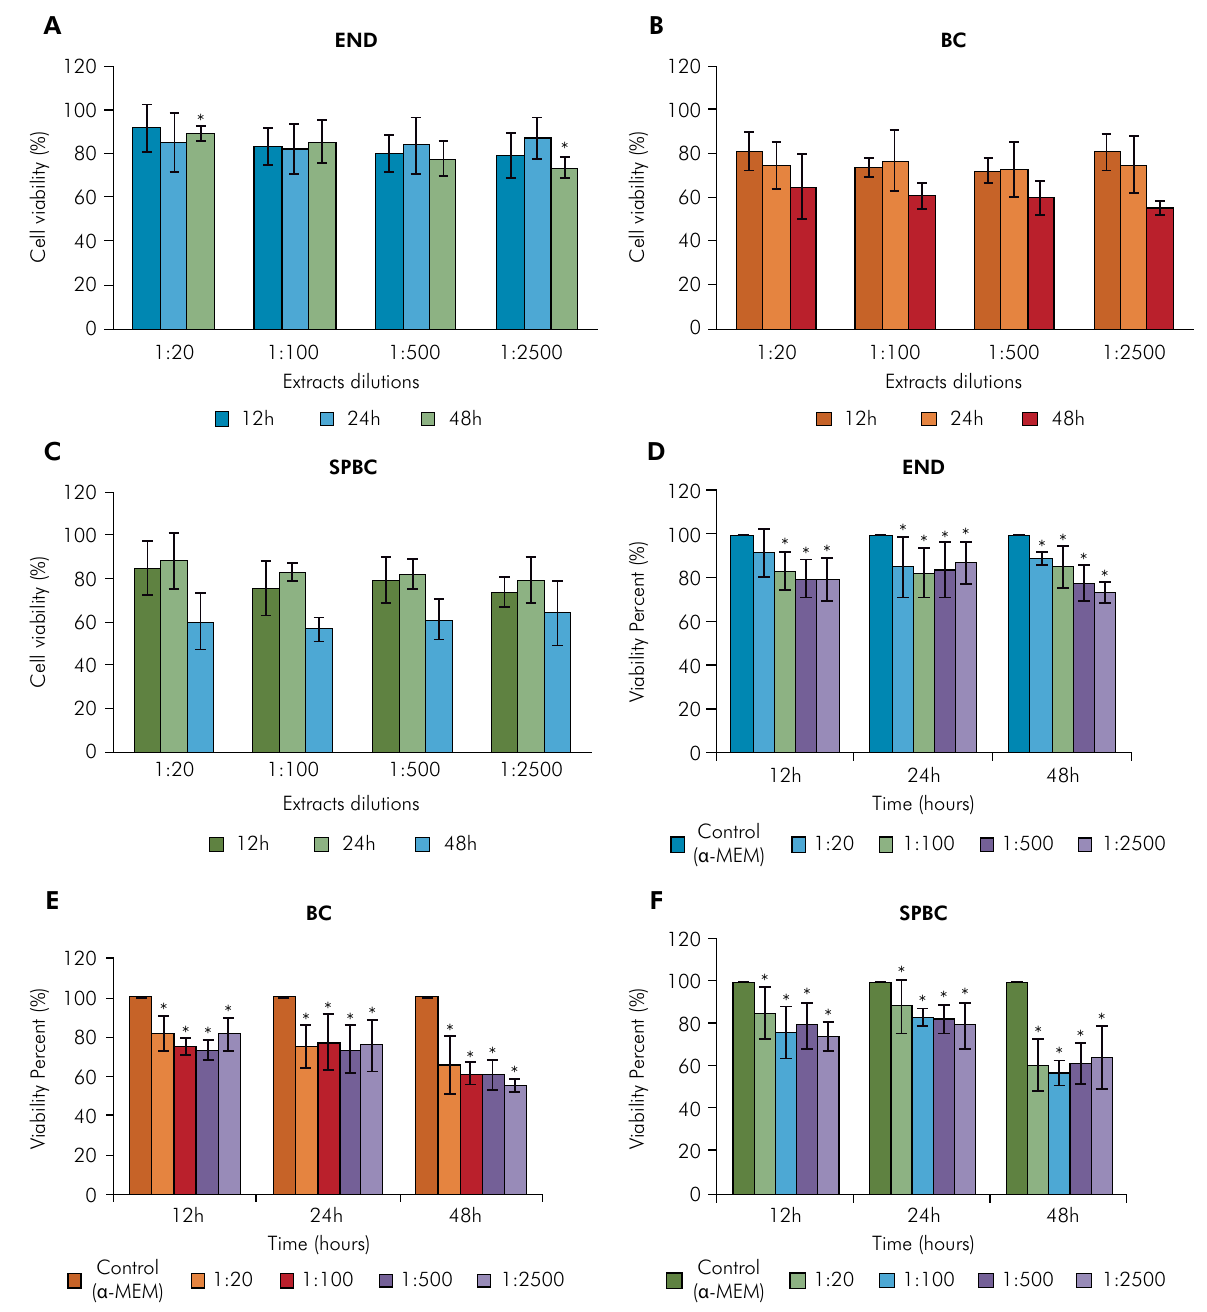
Figure 3. Viable cells (%) by MTT assay of the sealer extracts in several dilutions at different experimental time points. (A) END dilutions; (B) BC dilutions; and (C) SPBC dilutions. Time-dependent effects of (D) END; (E) BC; and (F) SPBC extracts. A 100% cell viability was considered for the control group ( α -MEM). Asterisk indicates a significant difference (p <